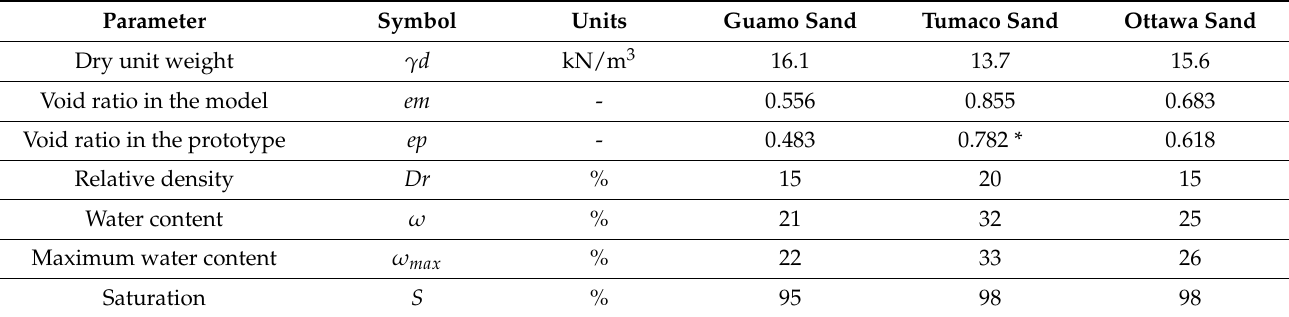
Table 3. Common initial conditions of the samples for all tests.